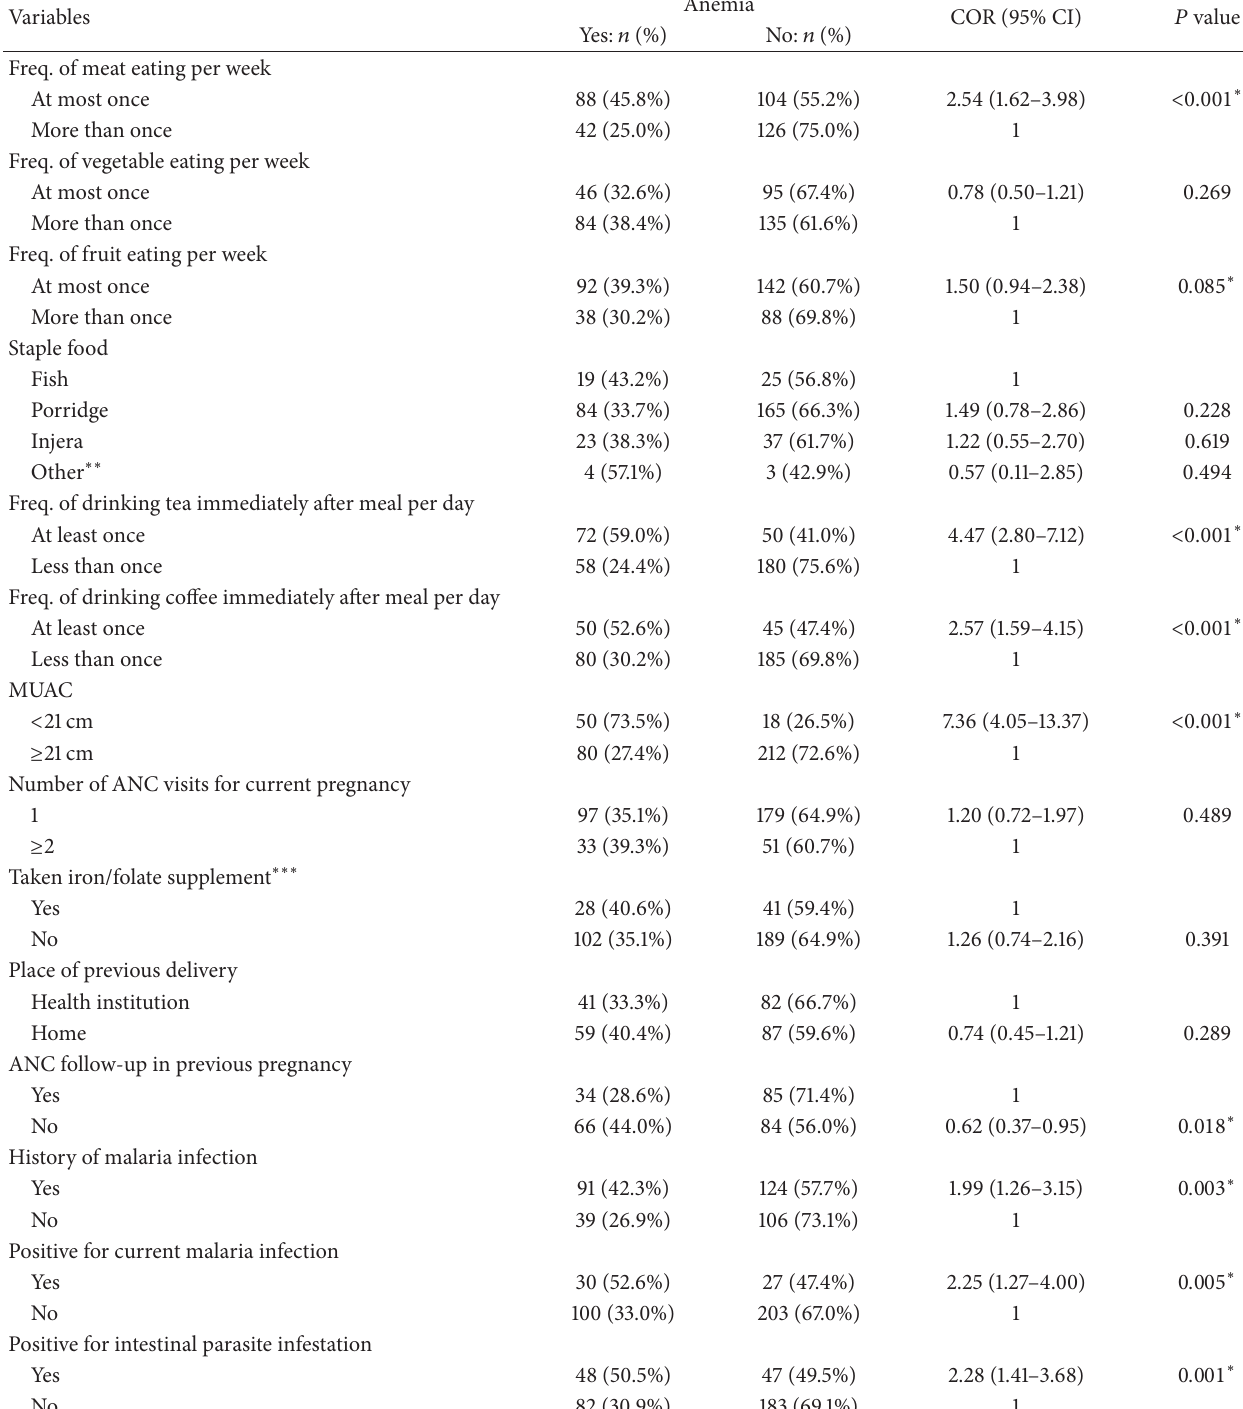
Table 3: Nutrition and clinical characteristics of refugee pregnant women attending ANC clinic at Pugnido ARRA Health Center,